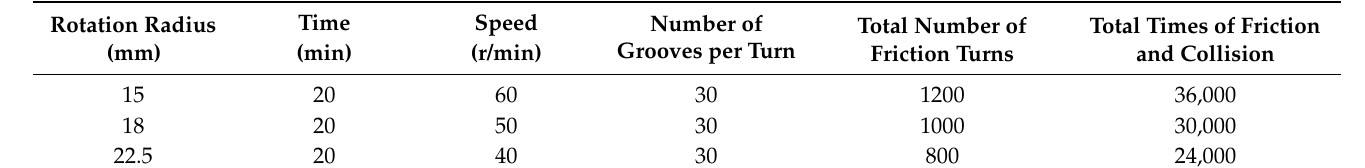
Table 6. Collision parameters with different radius of rotation.